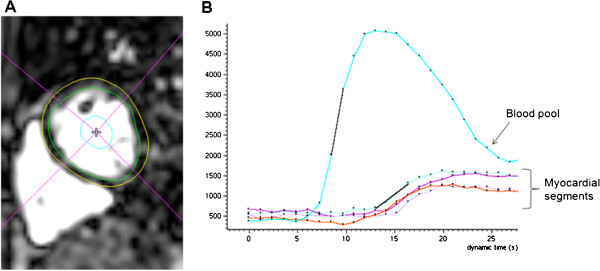
A. Example of myocardial tracing and segmentation in a short-axis slice. Endocardial border is shown in green and epicardial border in yellow. The LV myocardium was segmented into 4 sectors (anterior, lateral, inferior, septal). B. Blood pool and segmental myocardial time-intensity curves. Maximum up-slopes (black lines) were determined for the blood pool and for each myocardial segment; the mean myocardial up-slope was then normalized to the blood pool up-slope.